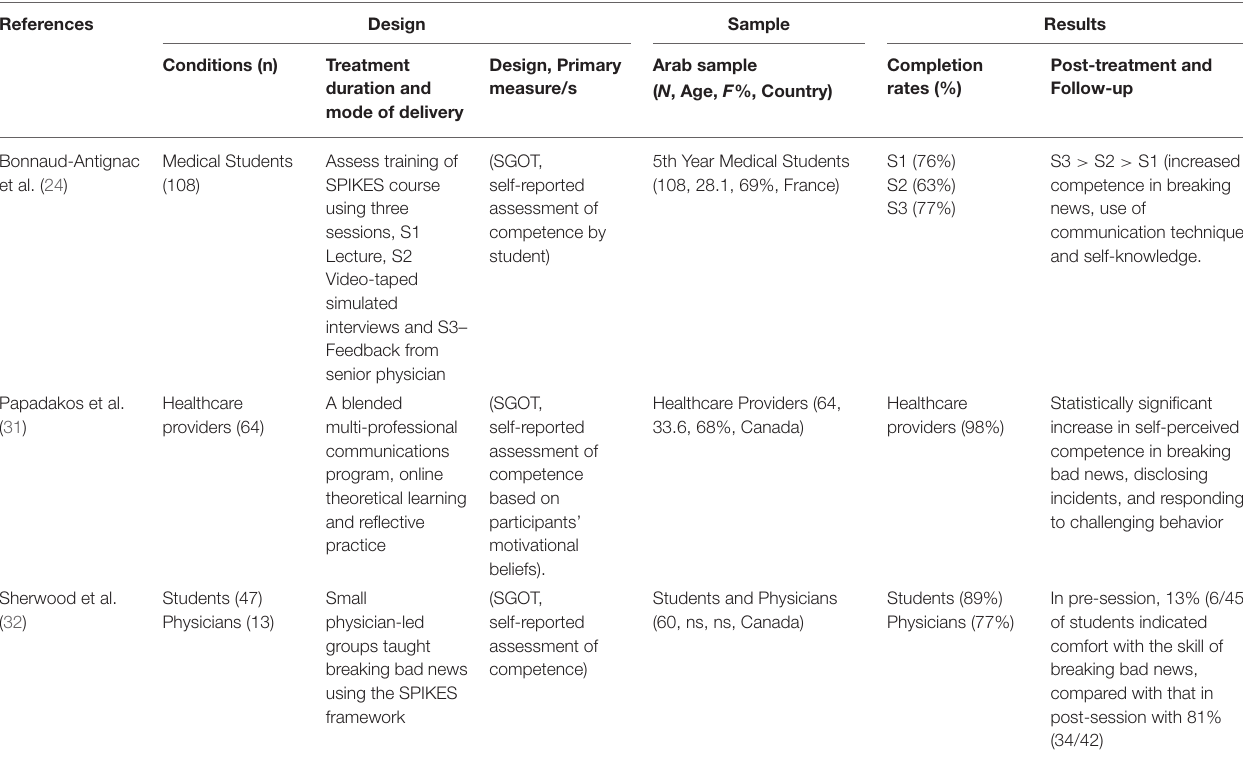
TABLE 3 | Summary of feasibility studies of SPIKES with a quality of evidence rating of